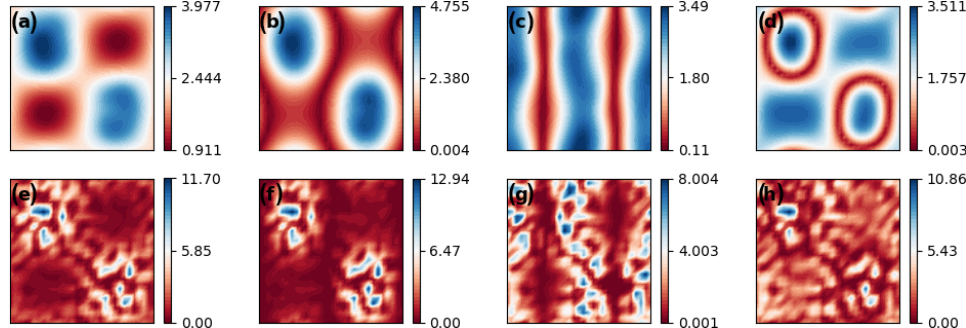
Figure 5. (a–d) Leading four eigenvectors of C in the γ 50 experiment. (e–g) Leading four eigenvectors of C in the γ 1